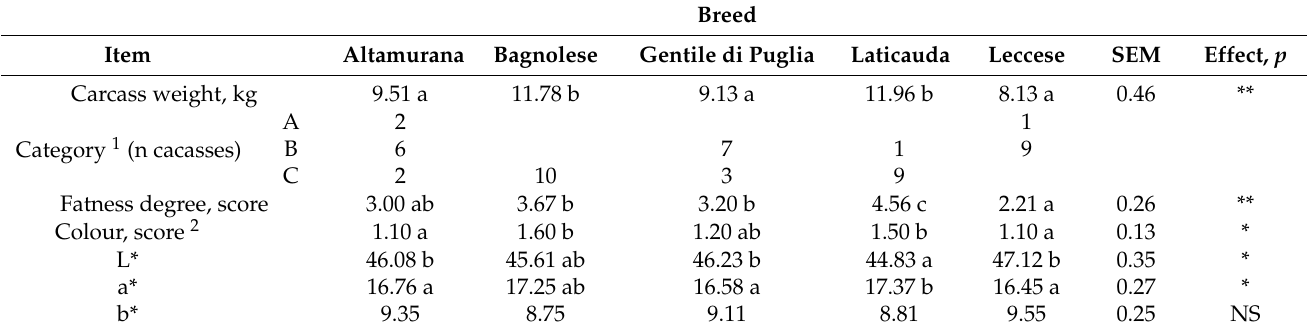
Table 1. Carcass traits of breeds reared in continental Southern Italy according to the EU classification system for light lambs (means ±